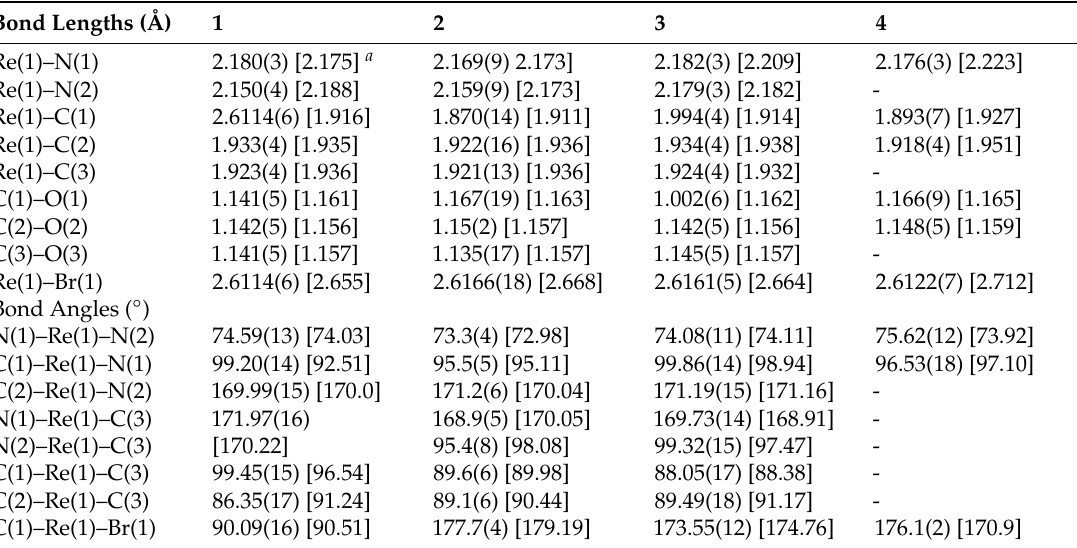
Table 2. Selected bond lengths (Å) and angles ( ◦ ) of 1 – 4 .